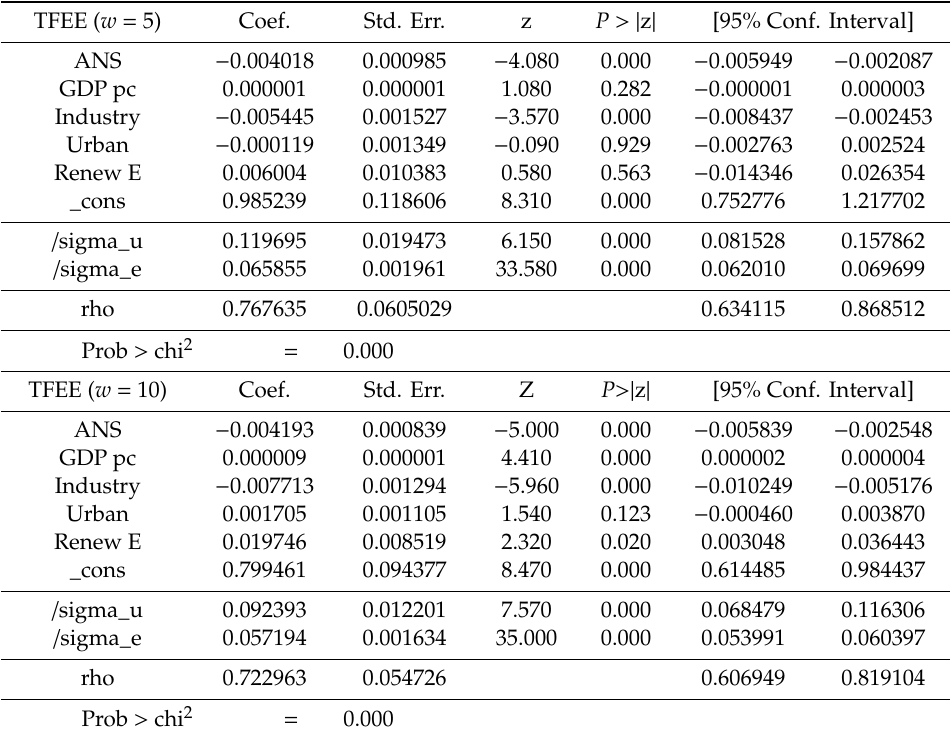
Table 7. Tobit regression model results of sustainable economic development variable